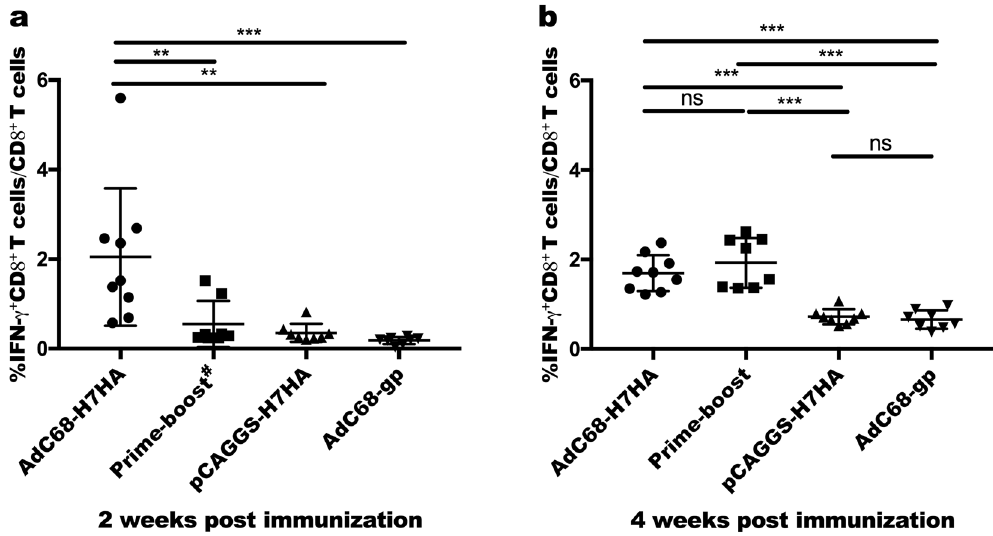
Figure 2. H7N9 virus-specific T cells responses. Two and 4 weeks after immunization, mouse PBMCs (peripheral blood mononuclear cells) were separated and collected. PBMCs were stimulated with H7HA peptide pools (10 μ g/mL) 2 hours before adding GolgiPlug TM for another 4 hours of incubation. The percentage of CD8 + T cells secreting IFN- γ was then measured by intracellular cytokine staining. ( a ) H7N9 virus-specific T cell responses at 2 weeks after prime immunization. ( b ) H7N9 virus-specific T cell responses at 4 weeks after prime immunization. The error bars represent the SD. *** p < 0.001; ** p < 0.01; * p < 0.05. # At 2 weeks post immunization, the prime-boost group received DNA priming, as in the DNA-only